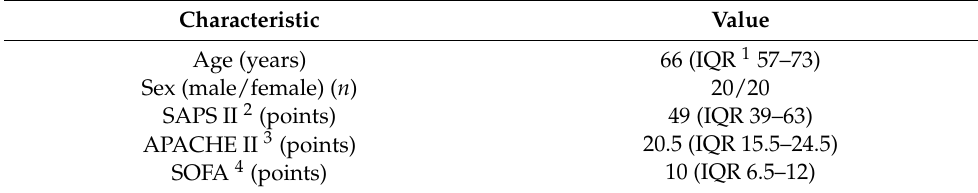
Table 1. The study population characteristics.